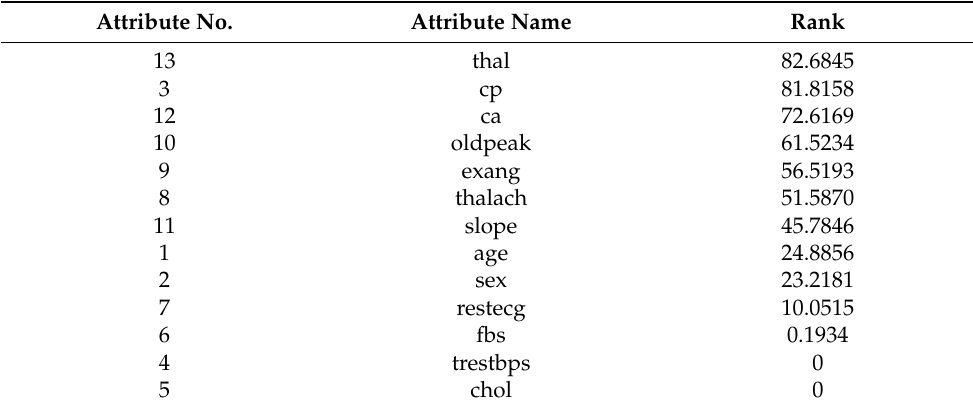
Table 4. Attribute sets that were obtained from the chi-squared attribute evaluation. Attribute